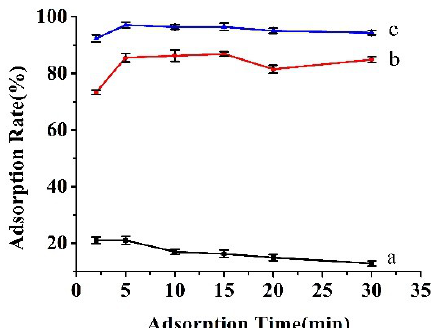
Figure 5. The influence of different alkyl groups on the adsorption. ( a ) Without any modification; ( b ) Octyl modification; ( c ) Dodecyl modification. 50 mg adsorbents in 10.0 mL solution (10 mg/L BPA); 34 mmol/L PBS, pH 7.0; 25 °C. The error bars represent standard deviation of three parallel experiments.